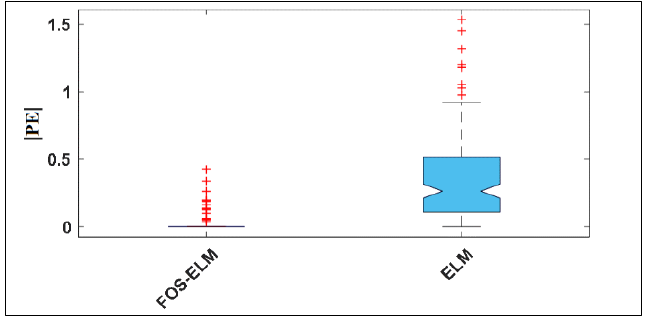
Figure 6. Box-plots of the prediction error |PE| of the variable forgetting factor (FOS-ELM) vs. the extreme learning machine (ELM) model between the observed and predicted solar radiation for all input combination M 7 . PE.